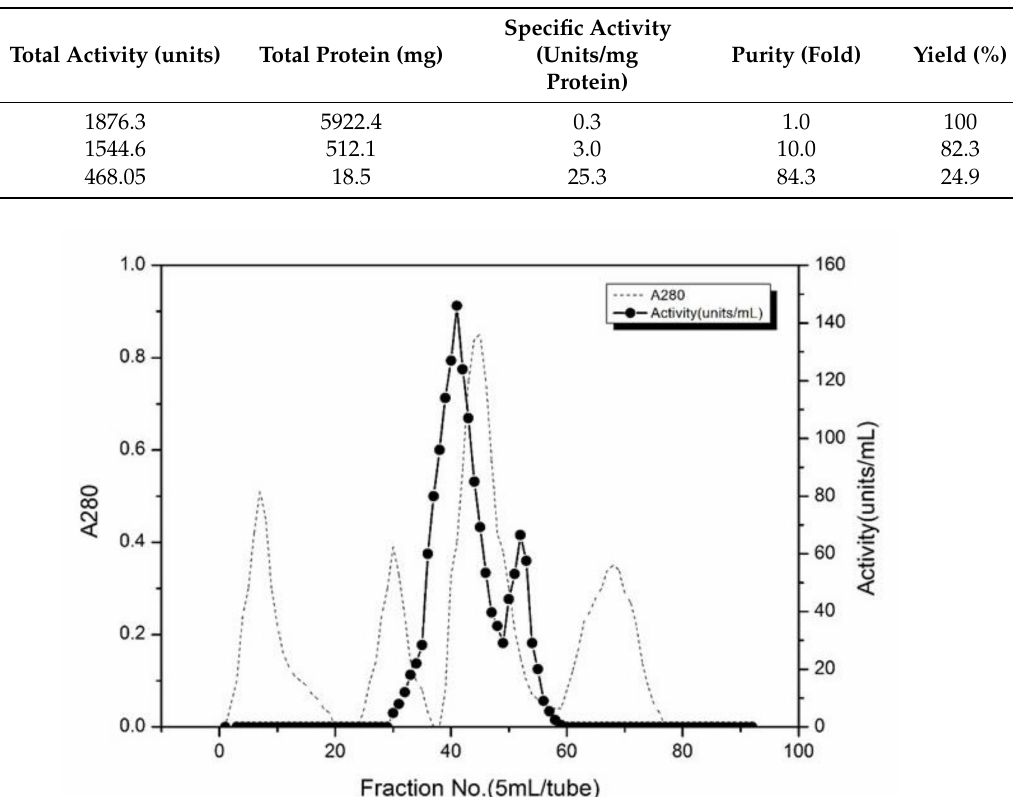
Table 1. Summary of trypsin purification from the pancreas of Litopenaeus vannamei .